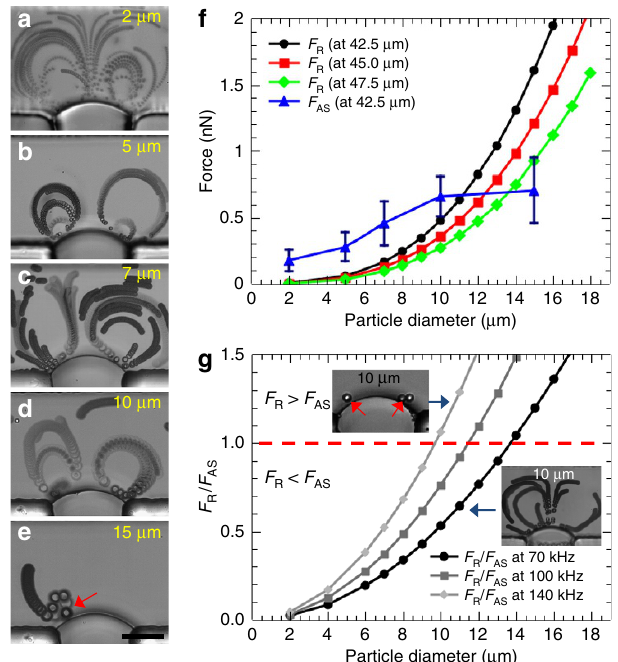
Figure 3 | Acoustic radiation and acoustic streaming force analysis on particles with different sizes. Image sequence demonstrating ( a – d ) acoustic microstreaming of 2, 5, 7 and 10 m m polystyrene particles and ( e ) subsequent particle trapping of 15 m m particles at excitation frequency and amplitude of 70kHz and B 3 m m, respectively. ( f ) Plots of acoustic streaming (triangle, F AS ) and radiation ( F R ) forces. The radiation forces for three different particle-microbubble centre are plotted at 42.5 (circle), 45 (square) and 47.5 m m (diamond). ( g ) The ratio of acoustic radiation to streaming forces at 70, 100 and 140kHz excitation frequencies are plotted. The insets of g shows 10 m m polystyrene particles being trapped (at 140kHz) and following the streaming flows (at 70kHz). Error bars represent standard deviation ( n Z 5). Scale bar, 50 m force and as f 4 0, microparticles are attracted towards the microbubble.